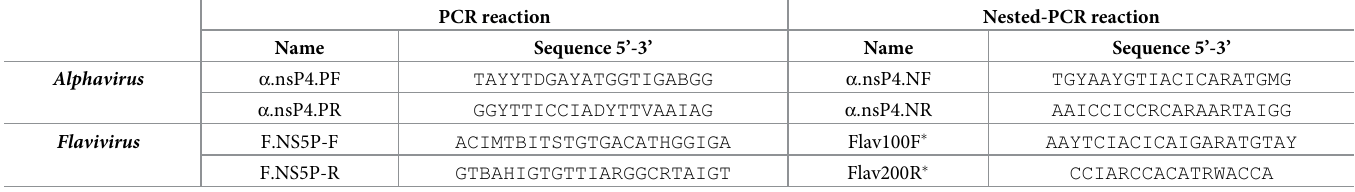
Table 1. Sequences 5’-3’ of Alphavirus and Flavivirus specific primers used for Nested-PCR